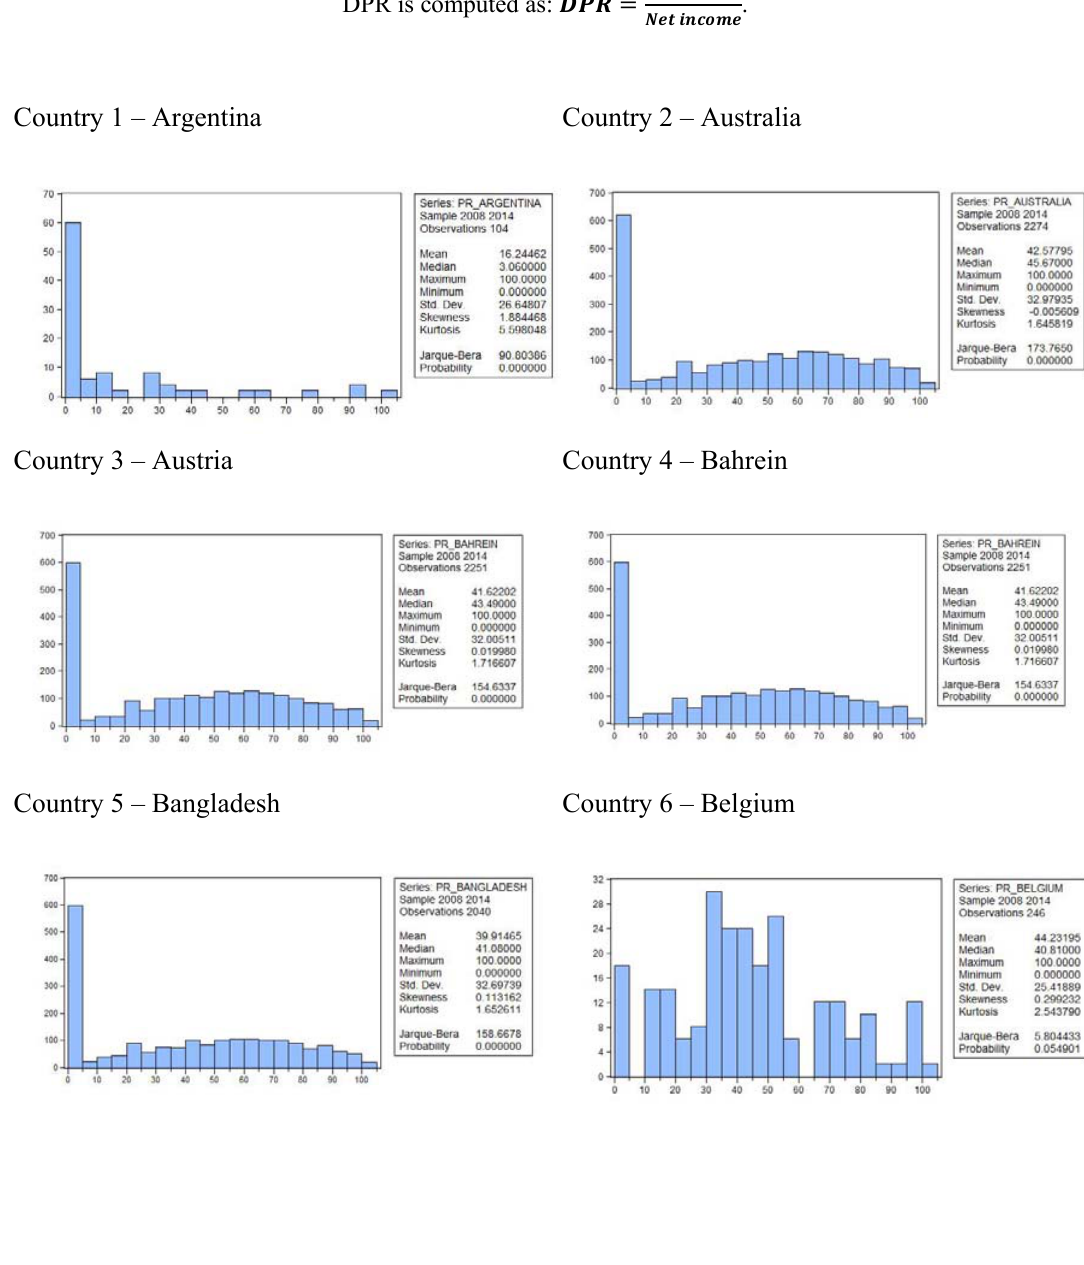
Figure A.1.1 : Dividend payout ratio for the companies included in the sample (per country), in the period 2008-2014. All companies’ financials were collected from the Thomson Research Worldscope database. DPR is computed as: (cid:2160)(cid:2172)(cid:2174) (cid:3404) (cid:2160)(cid:2191)(cid:2204)(cid:2191)(cid:2186)(cid:2187)(cid:2196)(cid:2186)(cid:2201) (cid:2170)(cid:2187)(cid:2202) (cid:2191)(cid:2196)(cid:2185)(cid:2197)(cid:2195)(cid:2187)